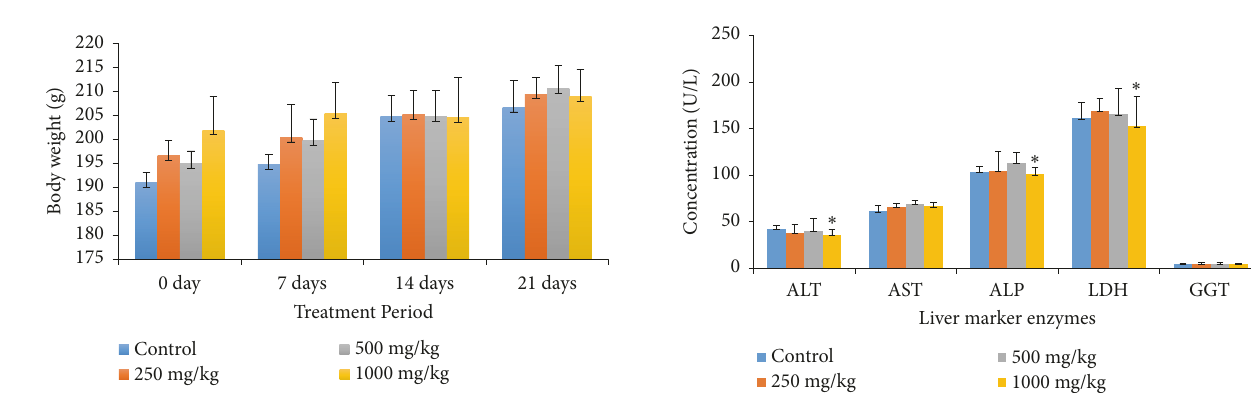
Figure 2: The effects of different concentrations of pomelo methanolic extracts on serum hepatic marker enzymes. Results are expressed as mean ± SD (n=8). ∗ denotes the level of significant difference when compared to the control group as determined by a one-way ANOVA followed by Dunnett’s multiple comparison